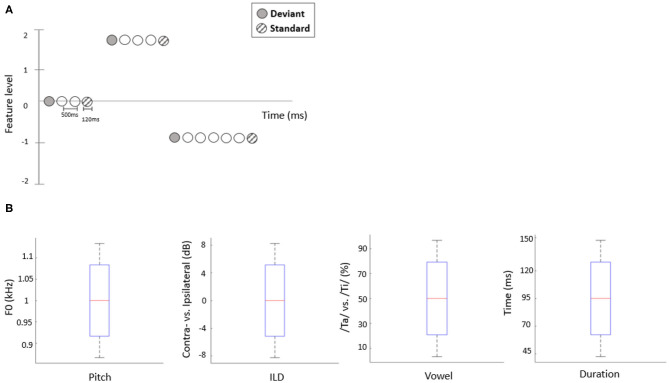
(A) Schematic representation of the stimulation sequences. The first stimulus in each train (solid circles) represents a deviant sound, while the last (hatched circles) represents a standard sound. (B) The range of each acoustic feature used to construct stimuli in the EEG experiment. Red line indicates the median value of each feature (across participants), blue bars and black whiskers represent mean and SD of upper and lower ranges across participants.